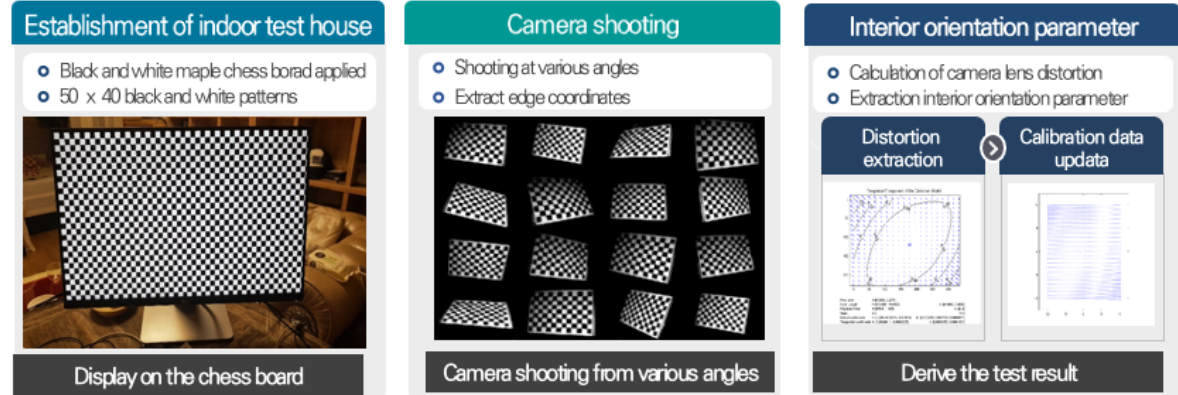
Figure 3. Manual-calibration procedure using Camera Calibration Toolbox for Matlab